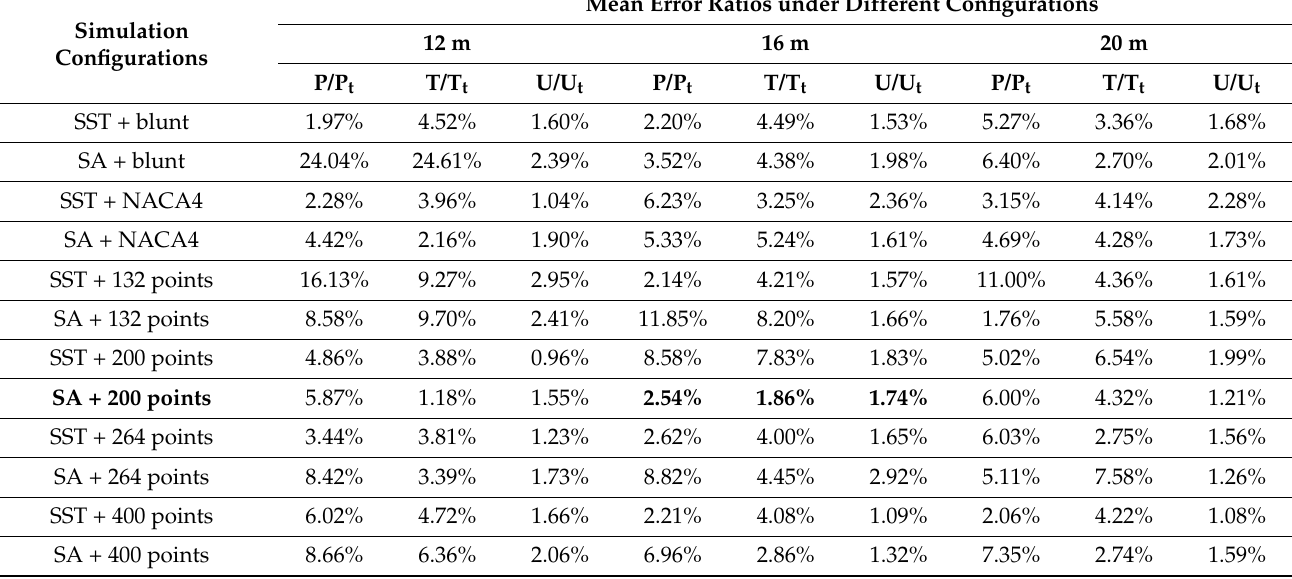
Table 23. The mean error ratios of P/P t , T/T t , and U/U t of the ROE flux type.